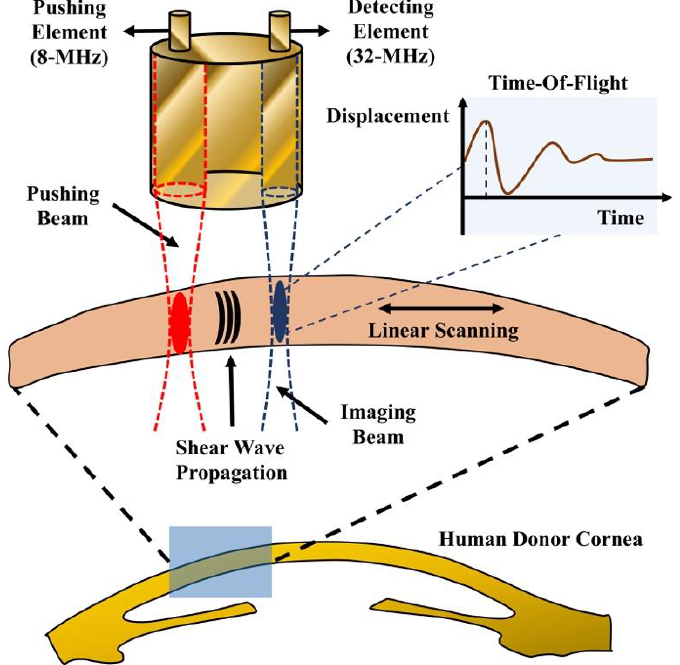
Figure 4. Timing diagram for the pushing and imaging sequences. A linear scanning was performed to measure the GSWV at different lateral locations.